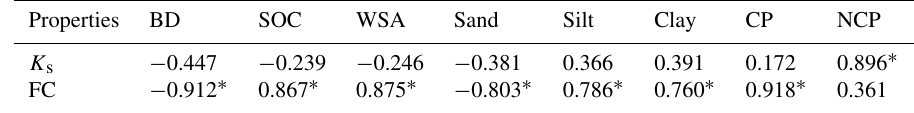
Table 3. Pearson correlation coefficients between K s , FC and soil properties of soil in layers above 20cm depth. Properties BD